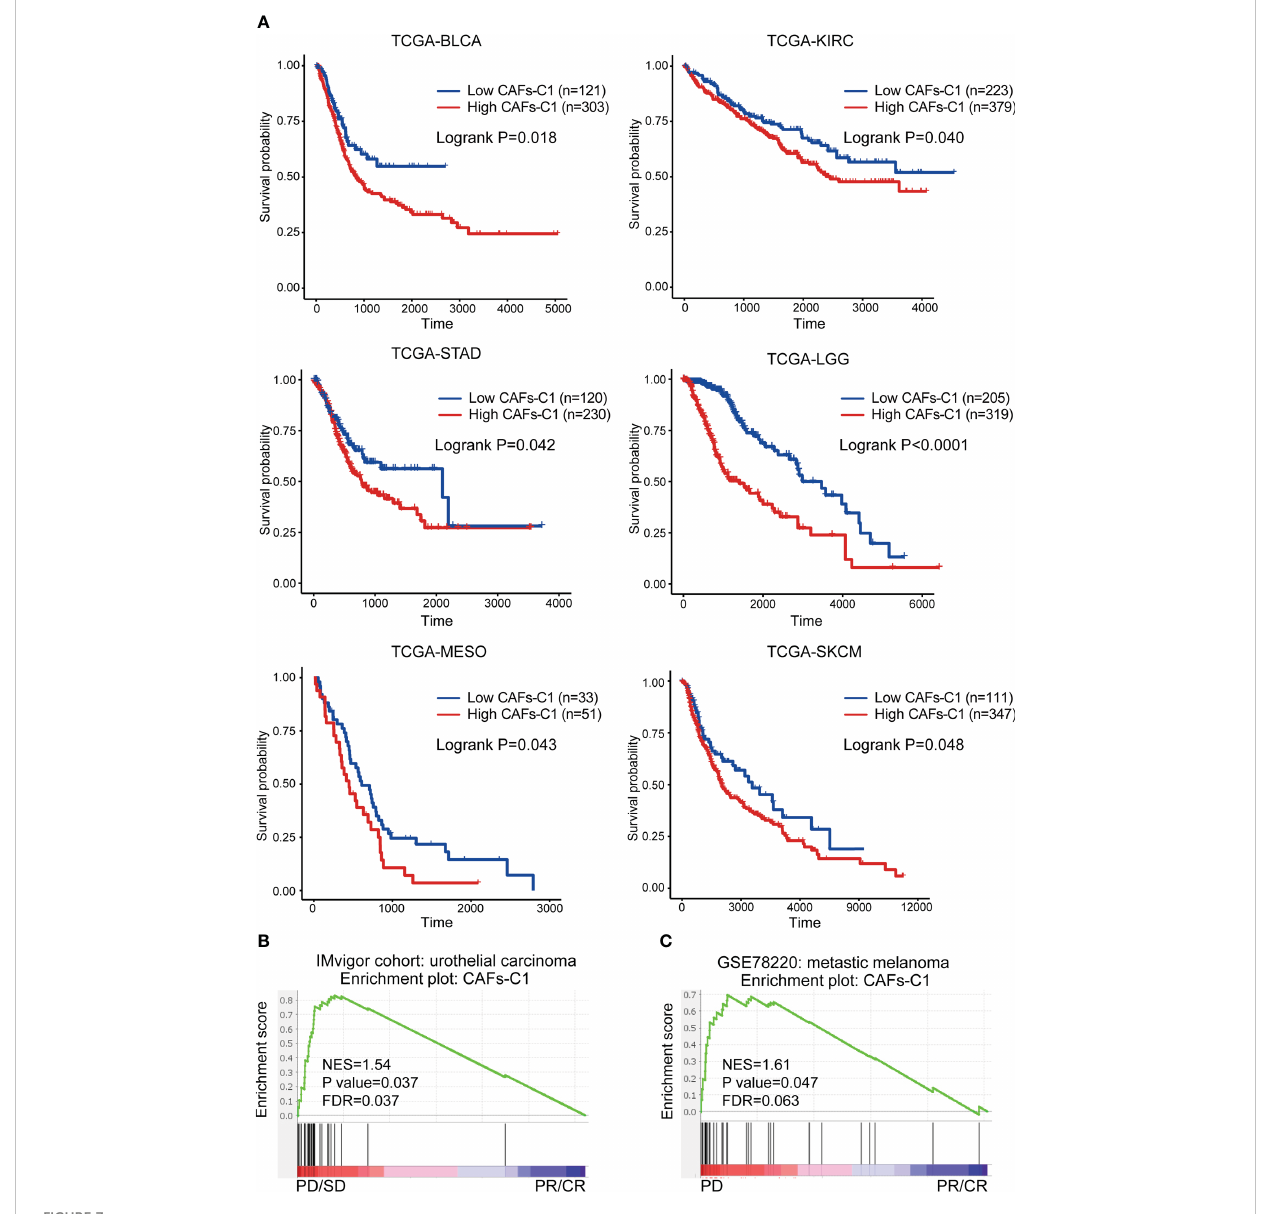
FIGURE 7 Clinical signi fi cance of CAFs-C1 signature in distinct cancer types. (A) Kaplan-Meier analysis comparing the overall survival differences among patients with high and low CAFs-C1 signature in TCGA-BLCA, TCGA-KIRC, TCGA-STAD, TCGA-LGG, TCGA-MESO, and TCGA-SKCM datasets. (B) GSEA analysis for meta-static urothelial carcinoma patients treated with anti-PD-L1 showing signi fi cant enrichment of CAFs-C1 signature in the PD and SD patients compared to CR and PR patients. (C) GSEA analysis for metastatic melanoma cancer patients treated with anti-PD1 showing signi fi cant enrichment of CAFs-C1 signature in the PD patients compared to CR and PR